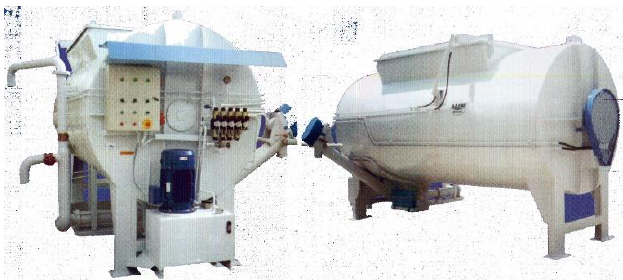
Figure 5. Lime mash/slurry storage and delivery machine under control. Figure 5. Lime mash / slurry storage and delivery machine under control.